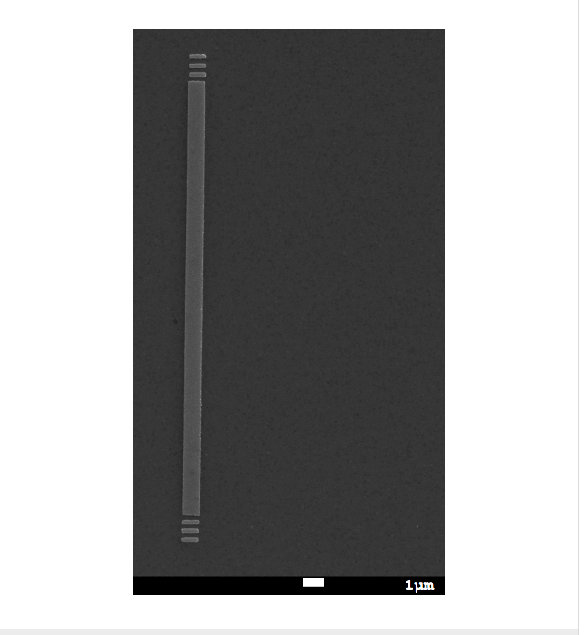
Figure 2: SEM image of 20 µm stripe with grating periodicity of 408 nm.